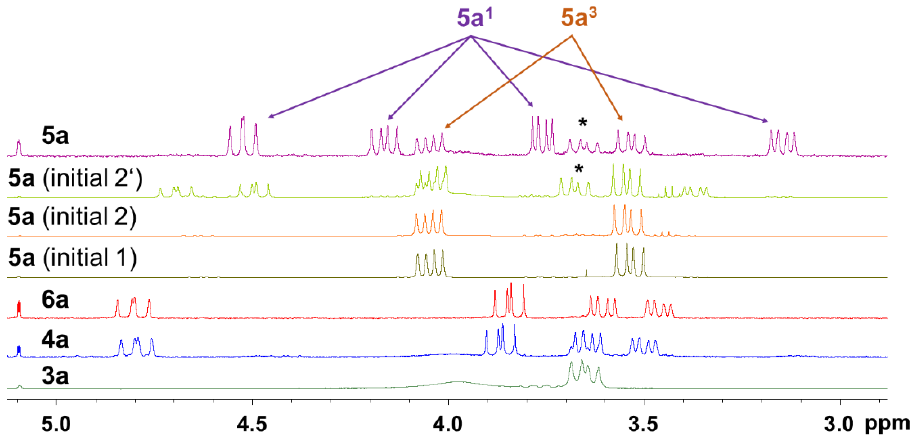
Figure 6. Section of the CH 2 signals of the 1 H NMR spectra of (from bottom to top) 3a , 4a , 6a and 5a in CD 2 Cl 2 (the signal at 5.1 ppm is a 1 J ( 13 C 1 H) satellite of CDHCl 2 solvent signal, the asterisks indicate signals of 3a